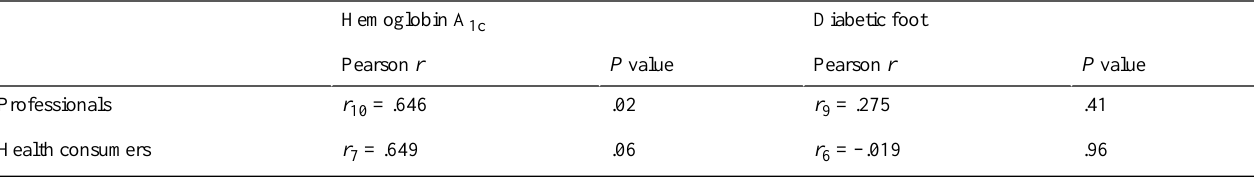
Table 5. Pearson correlation between ratings and